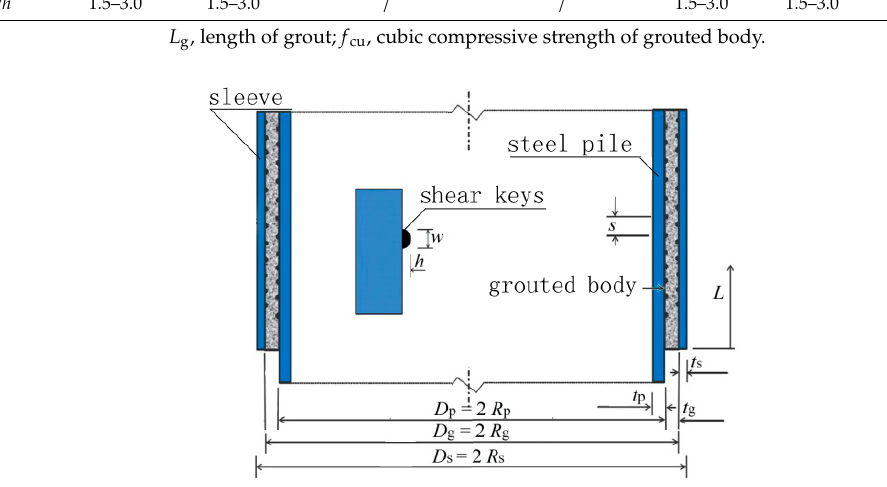
Figure 1. Geometric parameters of grouted connection. D p , diameter of steel pile; D g , diameter of grout; D s , diameter of sleeve; R p , radius of steel pile; R g , radius of grout; R s , radius of sleeve; t p , thickness of steel pile; t g , thickness of grout; t s , thickness of sleeve; w , width of shear key; h , height of shear key; s , spacing of shear key.